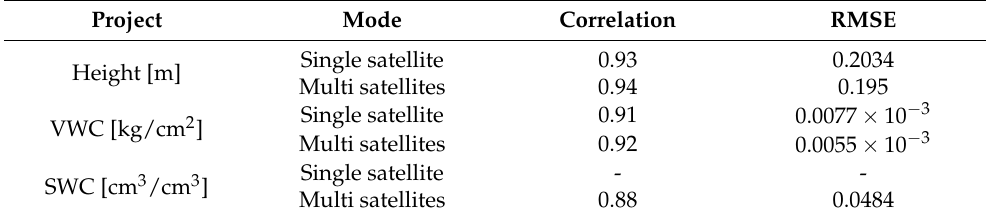
Table 1. Comparison between GNSS-IR retrieved results and in situ data.